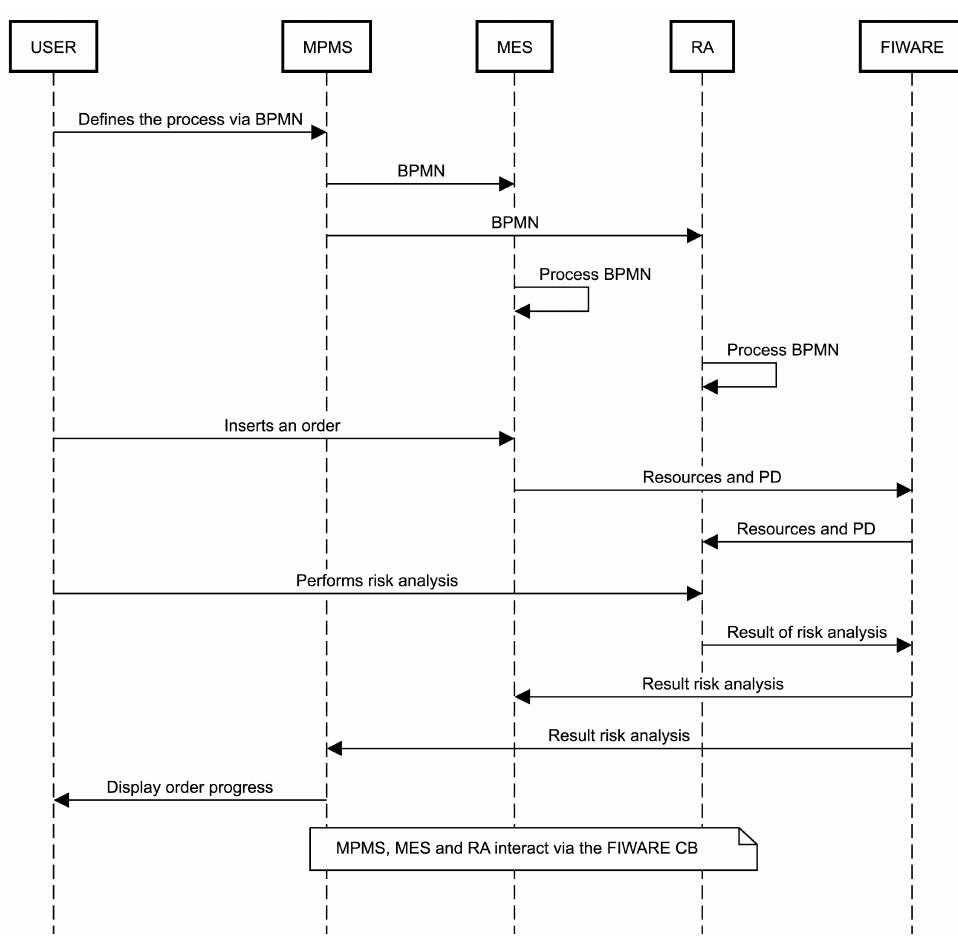
Figure 7. Sequence diagram of the workflow for performing a risk analysis using the proposed methods. Initially, the user defines the process via BPMN. Second, the BPMN is shared to the MES and RA to extract the process definition (PD). Third, the process definition is used by the user to assign resources . Fourth, the process definition and resources are sent to the RA for the risk